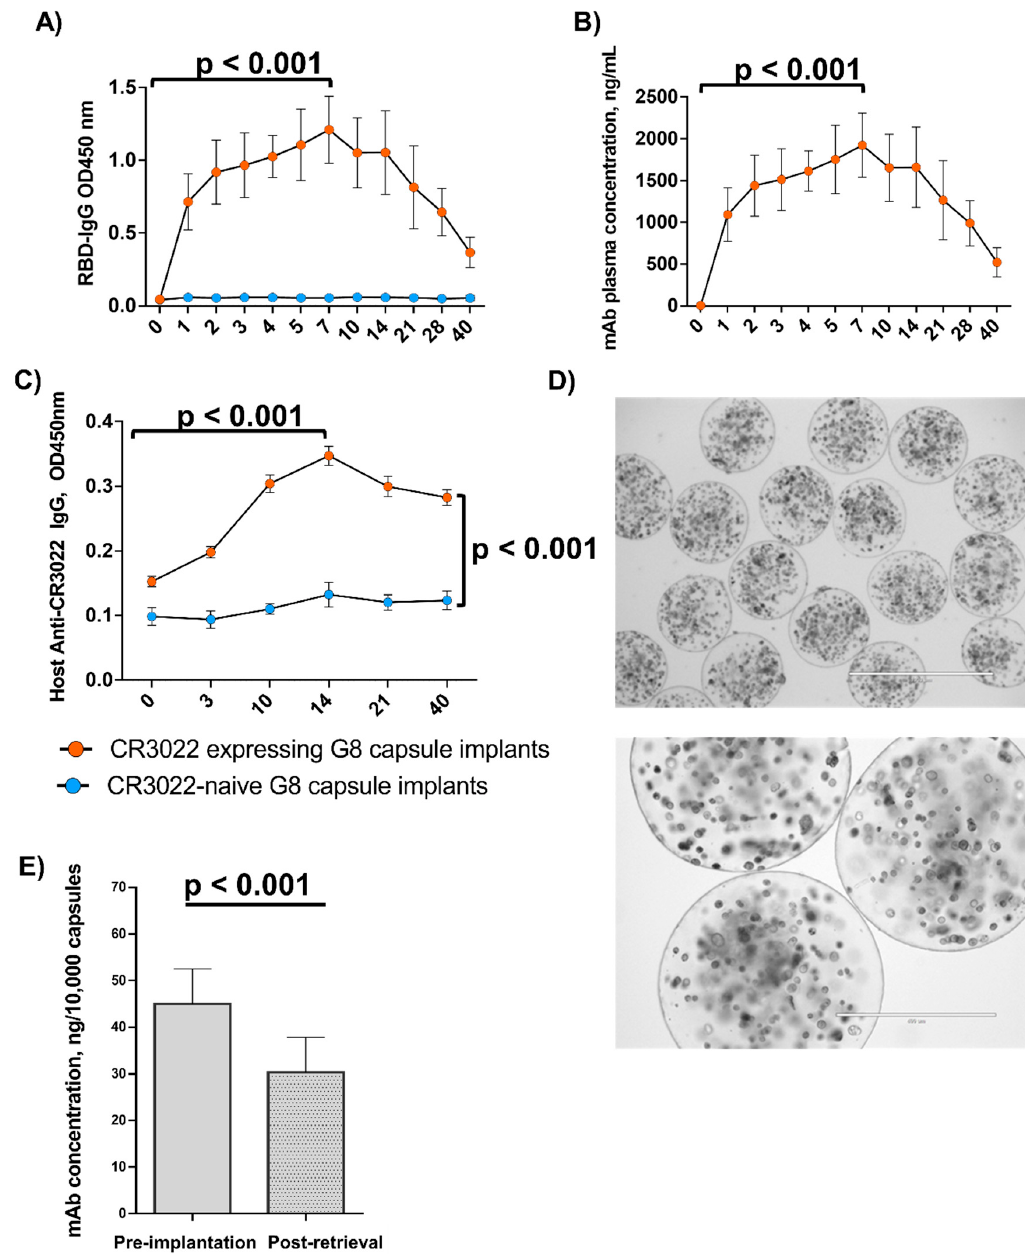
Figure 2. Changes in circulating SARS-CoV-2 mAb titres after microcapsule implantation. Plasma for the ELISA assays was extracted from mouse blood collected pre-implantation (day 0) and on consecutive days up to day 40 post-implantation. ( A , B ) RBD-IgG ELISA results depicted as OD450 measurements ( A ) and as mAb concentration normalized to the CR3022-naïve G-8 capsule implanted mouse plasma. ( C ) Mouse anti-human ab response, measured by ELISA. ( D ) Microphotographs of G-8 cell-containing alginate microcapsules extracted from the peritoneal cavity at 40 dpi. Microphotographs were obtained using light microscopy at ×4 (top panel) and ×10 (bottom panel) magnifications. ( E ) CR3022 secretion (defined as RBD-binding mAb concentration per capsule) pre-implantation and post-retrieval at day 40. Lines and brackets represent the geometric means and 95% confidence intervals, respectively. OD, optic density. In ( A – C ): The experimental and control groups consisted of six and four mice, respectively. In ( A , B , E ): mAb concentrations were calculated using a standard curve generated using a CR3022 mAb (NR-52481) from BEI on experimental readouts normalized to the corresponding baseline control (blood plasma from CR3022-naïve G-8 capsule implants) OD readouts (see Methods).